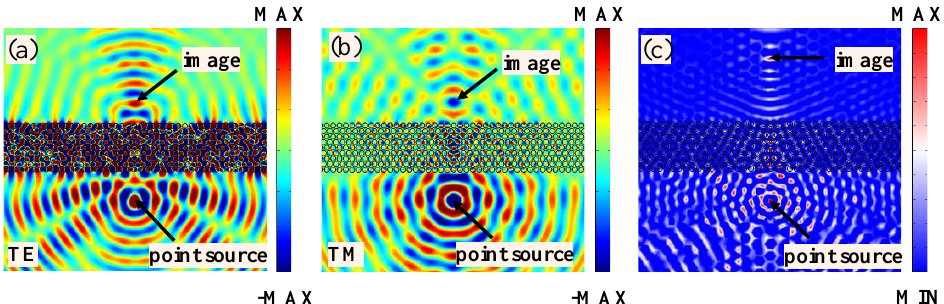
Figure 5. Slab-lens made of the PxC composed of 9 layers of silicon rods arranged in a triangular lattice and placed in air, based on which the imaging of TE, TM and acoustic modes can be achieved. The CW point source is located at the position below the lens with a distance of 5a, and the imaging point is formed above the upper side of the slab-lens. ( a ) Hz field patterns at the frequency of 0.3263(c/a) for TE mode. ( b ) Ez field patterns at the frequency of 0.2974(c/a) for TM mode. ( c ) The pressure field patterns at the frequency of 0.6927(v/a) for acoustic